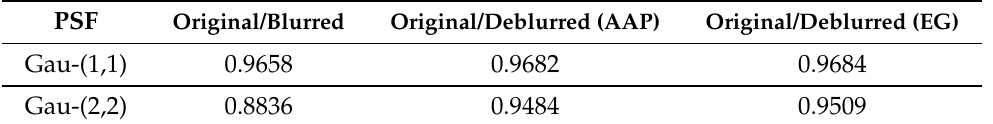
Table 1. Comparison of the original adapt-and-project (AAP) neural ICA method to the proposed exponentiated-gradient (EG) method: Coefficients of correlation between the original image and the blurred image and between the original image and the deblurred image.